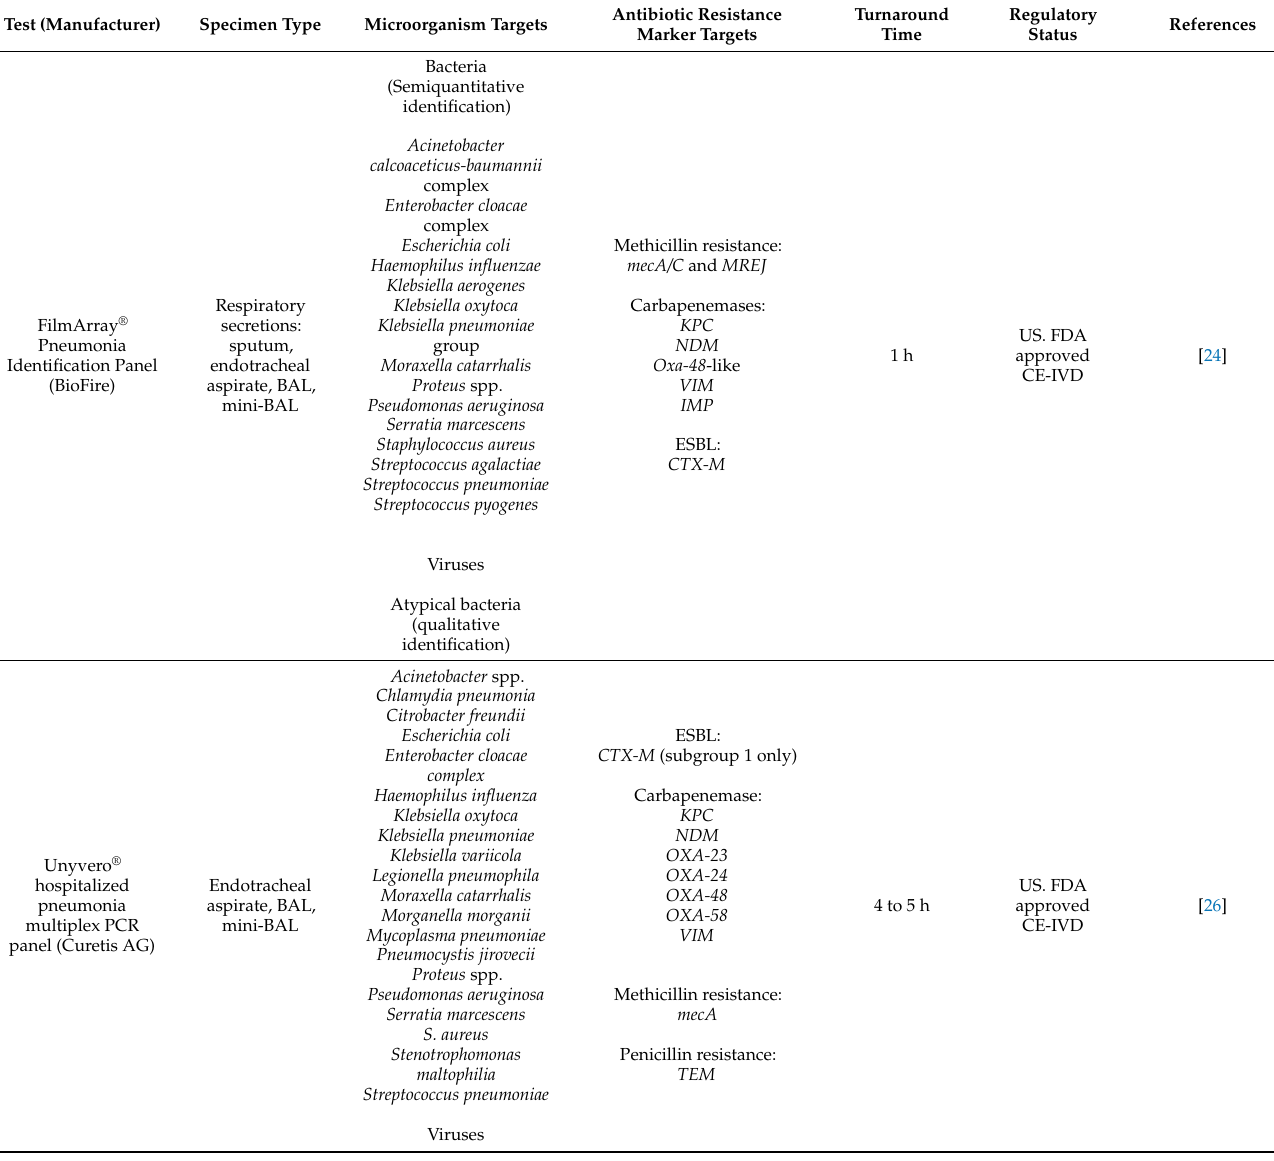
Table 1. Multiplex assays used for detection of multidrug-resistant pathogens causing